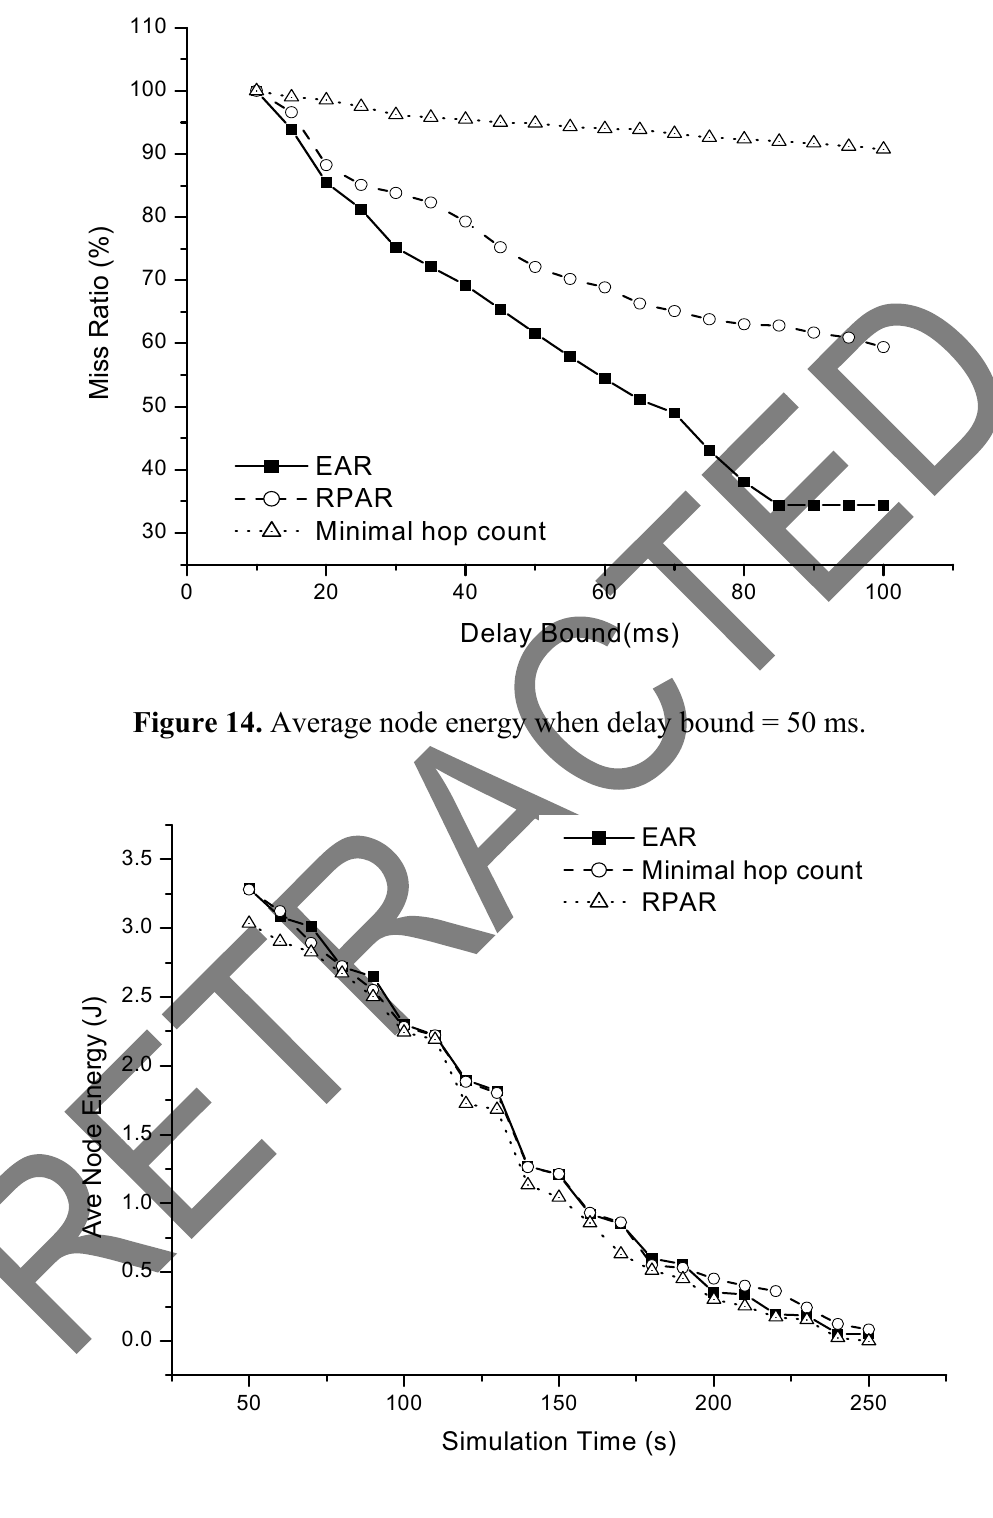
Figure 13. Miss ratio as delay bound increase.